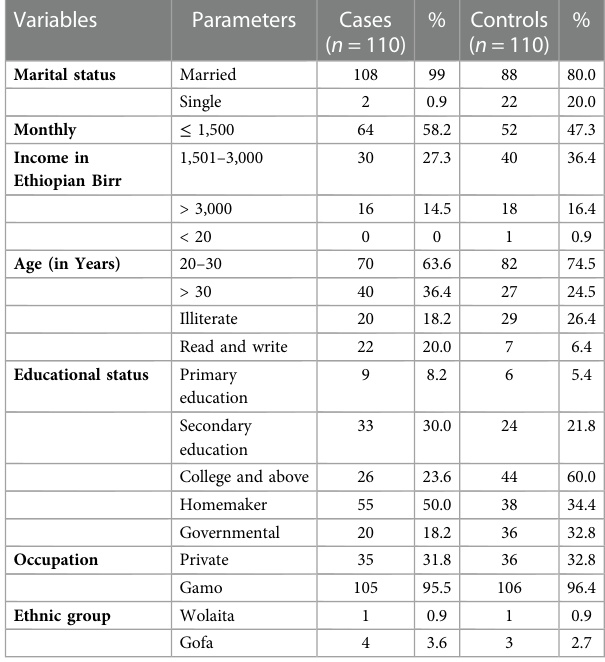
TABLE 1 Socio demographic characteristics of the study